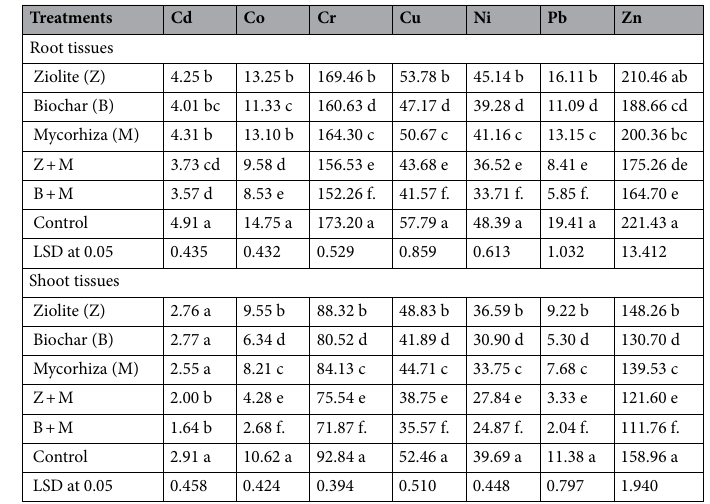
Table 1. Effect of soil amendments and mycorrhiza on heavy metals concentration (mg kg - 1 dw) in root and shoot tissues of cowpea plant grown in contaminated soil. Means followed with similar letters within the same column are not different significantly at P < 0.05 level of probability based on LSD test.